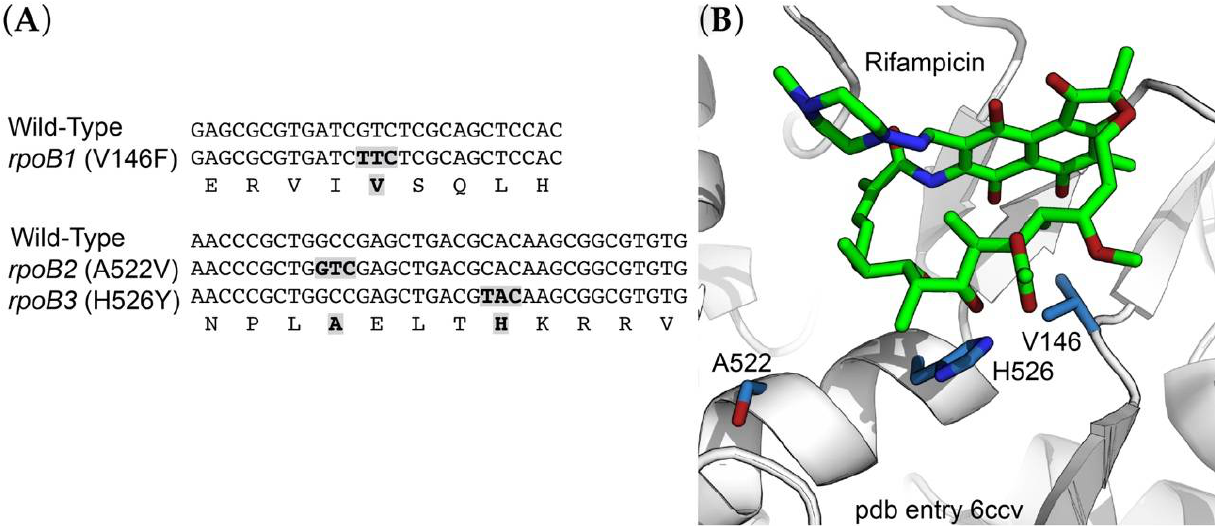
Figure 1. Sites of Rif R resistance mutations. ( A ) Alignment of a segment of RNA polymerase β-subunit sequence encompassing sites of Rif R mutations. ( B ) Structure of the rifampicin binding site within Mycobacterium smegmatis RNA polymerase [28], showing positions corresponding to sites of Rif R mutations in the R. marinus RNA polymerase β subunit.